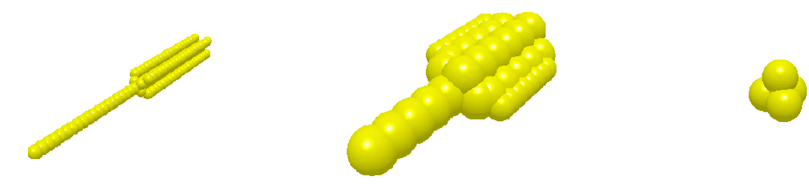
Figure 5. 3D models of particles.